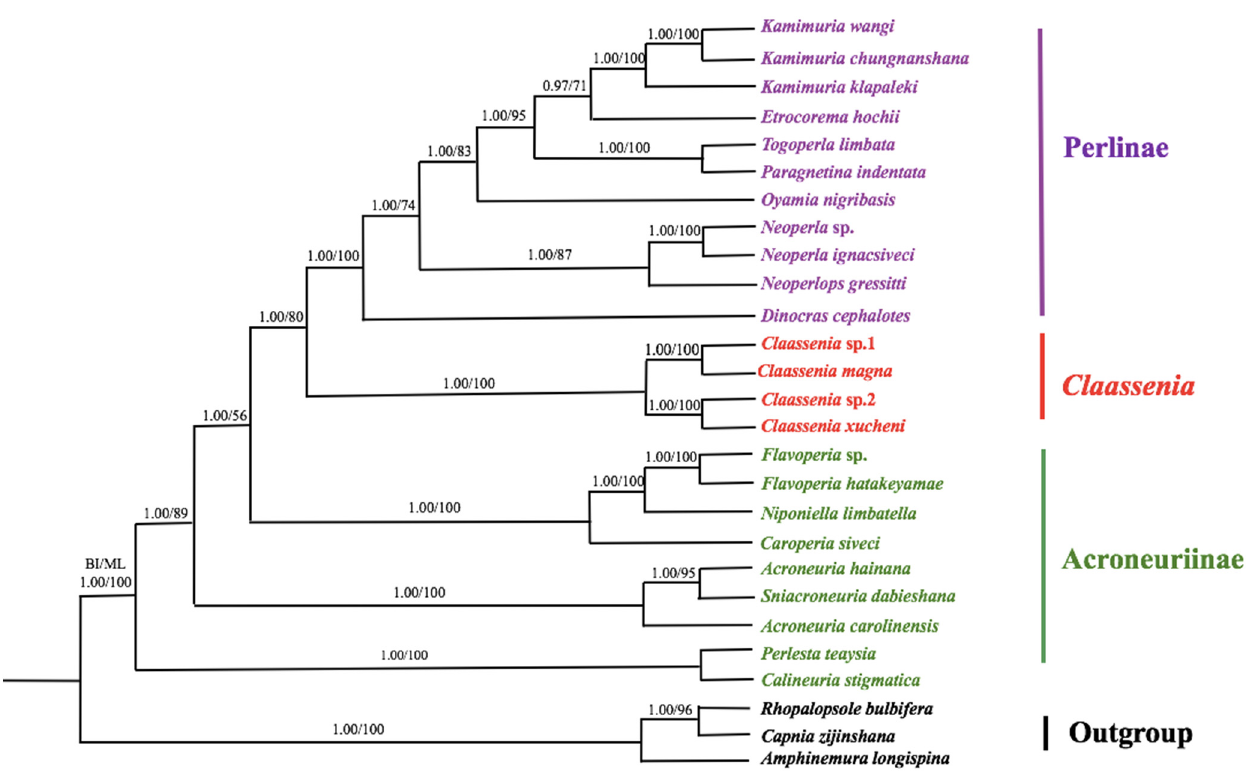
Figure 5. Phylogenetic tree based on mitogenomes of 27 stoneflies by using Bayesian inference (BI) and Maximum Likelihood (ML). Numbers at nodes represent posterior probabilities (left) and bootstrap values (right). Subfamily names and the genus Claassenia are marked to the right of each species. R. bulbifera , C. zijinshana and A. longispina served as outgroup species.